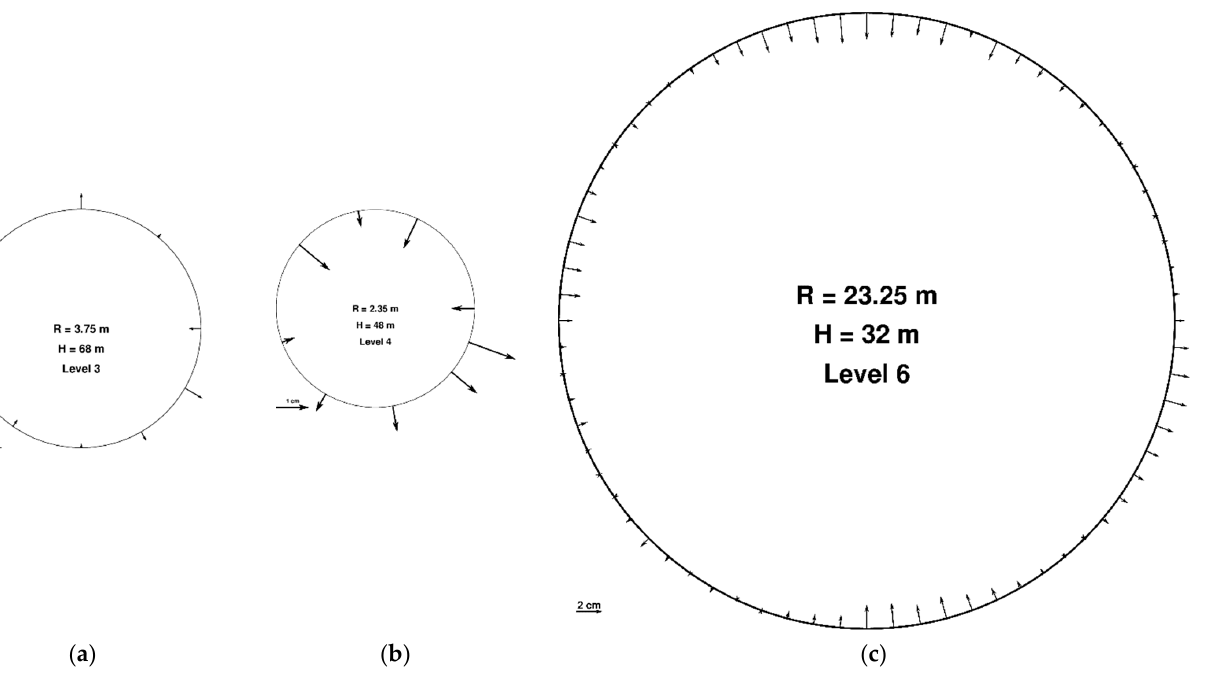
Figure 7. Representative graphs of circle fitting for: ( a ) wind turbine tower, ( b ) industrial smokestack, and ( c ) cooling tower. The deflection vectors are scaled with respect to the object size.